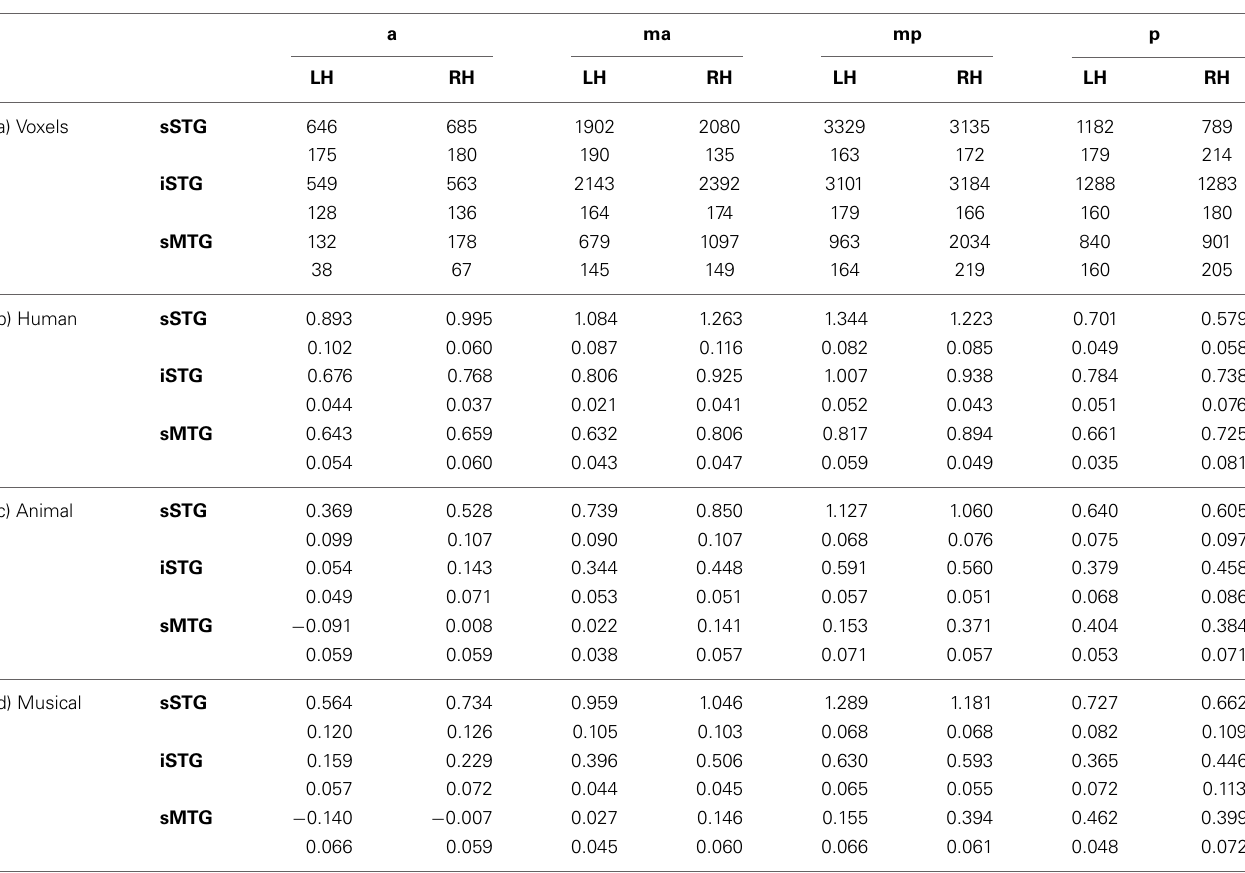
Table 5 | Details for the regions of interest identified by the separate-subject analysis.